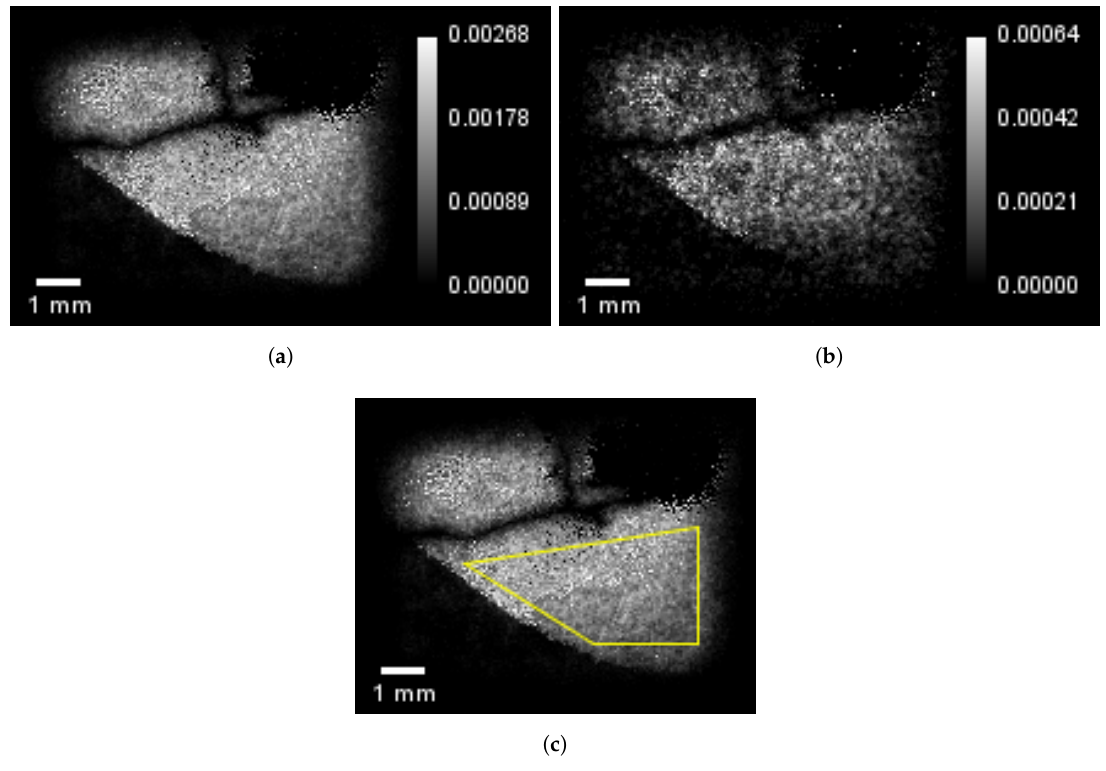
Figure 7. Neutron field response image to 2 mCi PuBe source. ( a ) thermalized PuBe source; ( b ) bare PuBe source; ( c ) thermalized PuBe source region of interest